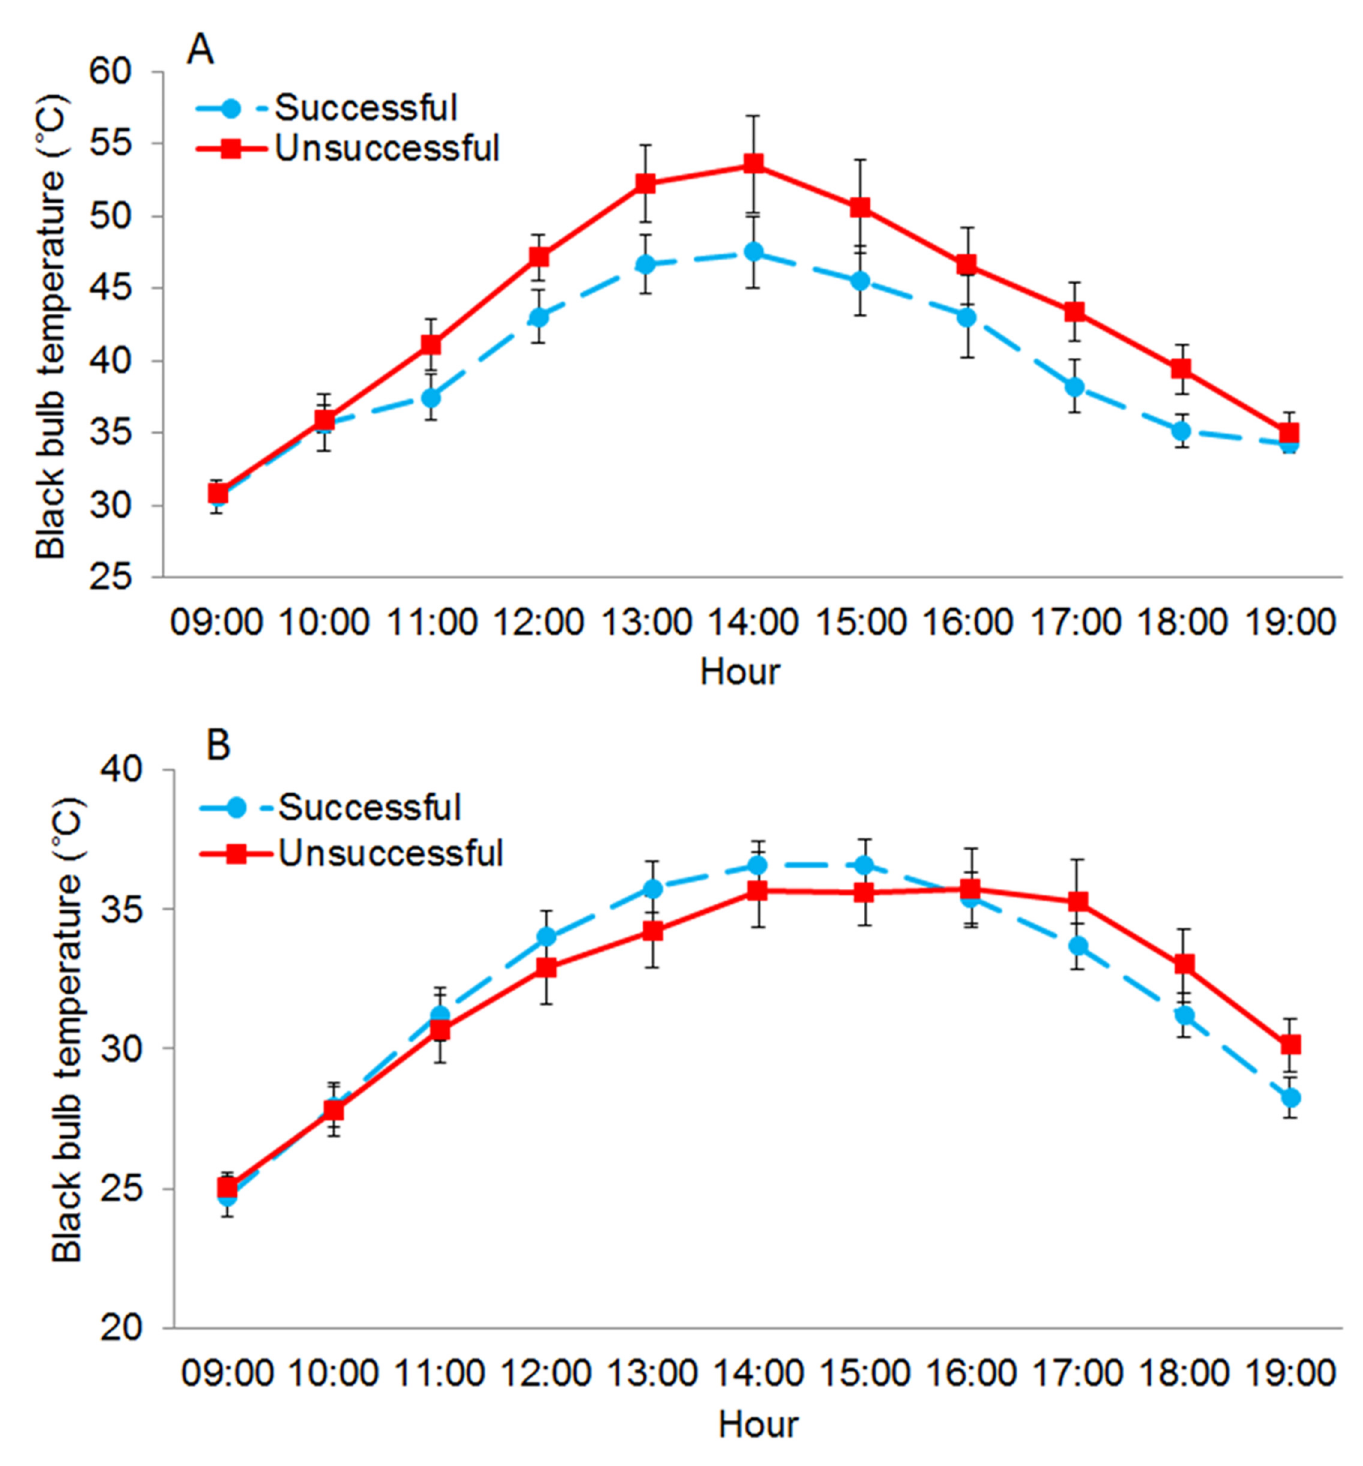
Fig 4. Successful nest sites moderated thermal environments more than unsuccessful nests during extreme heat. (A) Mean black bulb temperature (T bb ) ( ± SE) measured from 09:00 – 19:00 at successful (n = 54) (dashed line) and unsuccessful (n = 33) northern bobwhite nests (solid line) on days when maximum ambient temperature (T air ) was (cid:1) 39°C (n = 12) and (B) < 39°C (n = 75) at the Packsaddle WMA, Oklahoma, USA (2013 –